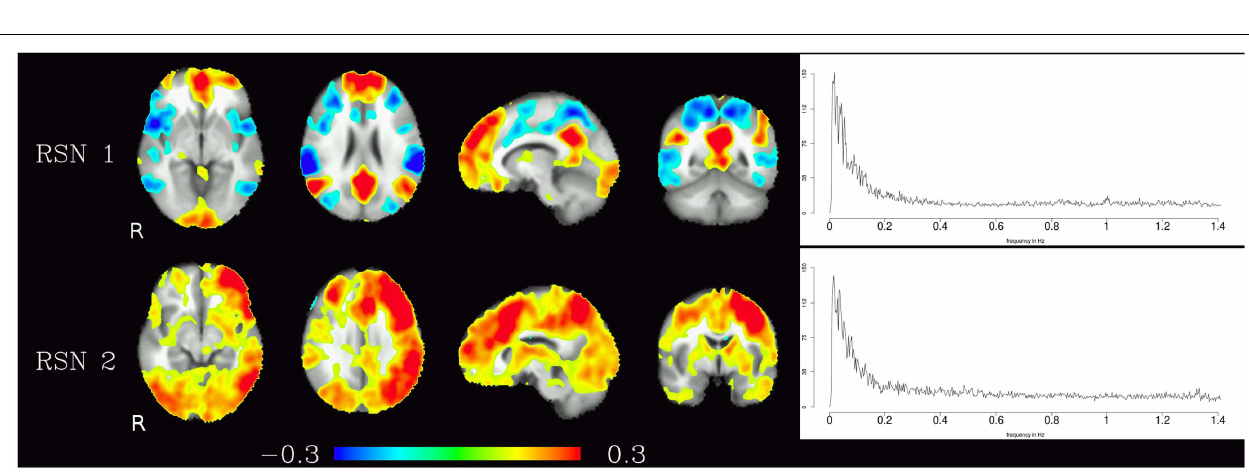
FIGURE 3 |Temporal ICA components from non-bandpassed data corresponding to the high-frequency resting-state networks in Figure 2. Figure layout, color scale, and threshold are identical to the ones in Figure 2